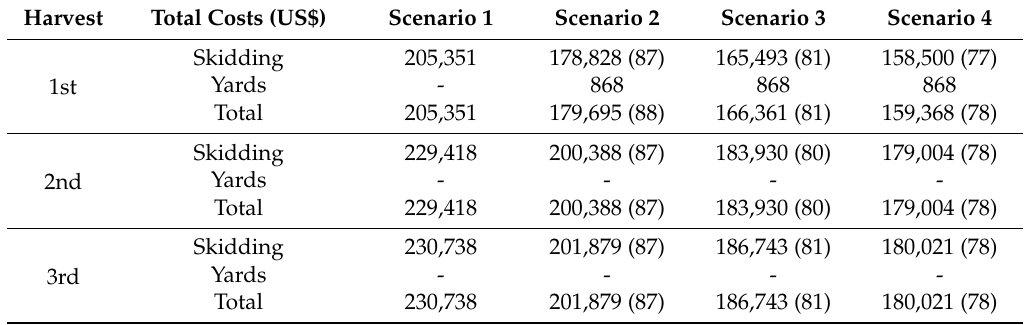
Table 4. Total costs of yards opening and skidding for the four scenarios. Numbers within parentheses indicate the difference in percentage (%) from scenario